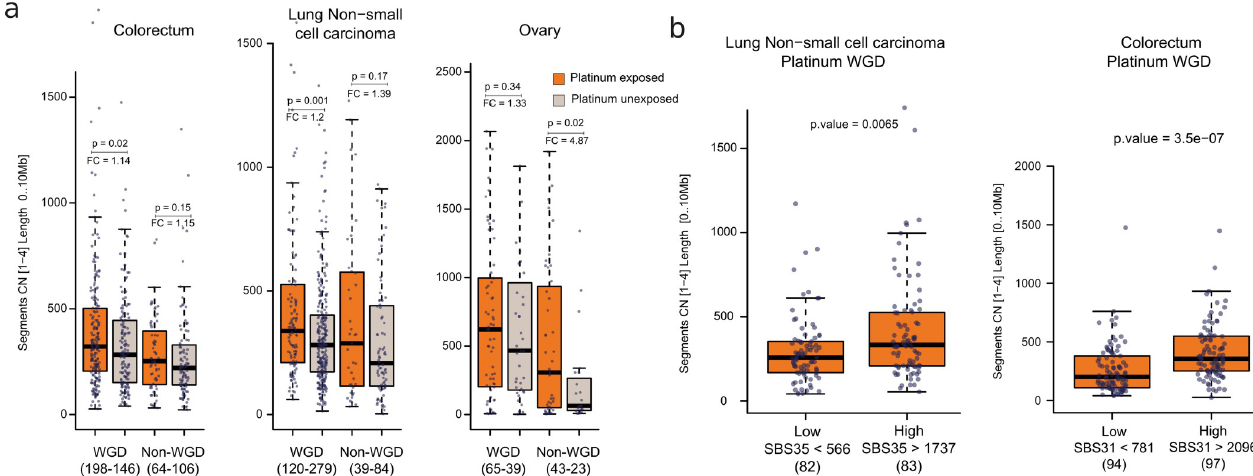
Fig 4. Relationship between the intensity of the treatment and CN footprint. a) Distribution of the number of chromosomal fragments with copy number 1–4 and length smaller than 10 Mb across WGD and non-WGD colorectal (left), lung (center) or ovarian (right) metastatic tumors exposed or unexposed to platinum-based drugs. The p-values were derived from a two-tailed Wilcoxon-Mann-Whitney test. Fold-change values (median number of CN fragments of size smaller than 10 Mb across exposed tumors vs its median across unexposed tumors) are shown. Boxes in the boxplot represent the limits of the first and third quartile of the distribution and the whiskers extend between its minimum and maximum, excluding the outliers. Tumors in each group are represented as dots. b) Distribution of the number of chromosomal fragments with copy number 1–4 and length smaller than 10 Mb across WGD lung (left) and colorectal (right) metastatic tumors in the lower or upper tertile of activity of the platinum SBS mutational signature. Boxes in the boxplot represent the limits of the first and third quartile of the distribution and the whiskers extend between its minimum and maximum, excluding the outliers. Tumors in each group are represented as dots. The p-values were derived from a two-tailed Wilcoxon-Mann-Whitney test.